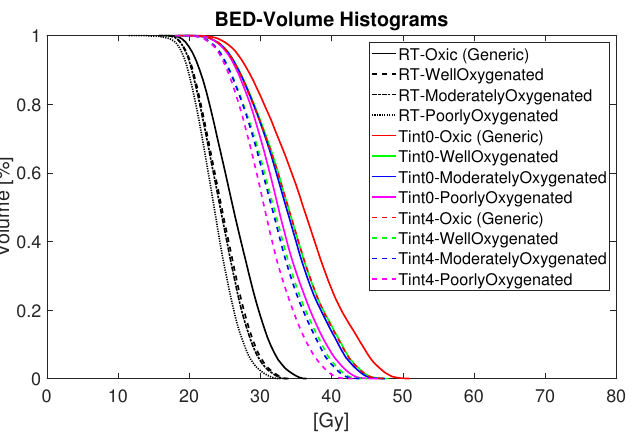
Figure 5. BED-Volume histograms for thermoradiotherapy plan with a total dose of 15 Gy given in five fractions.